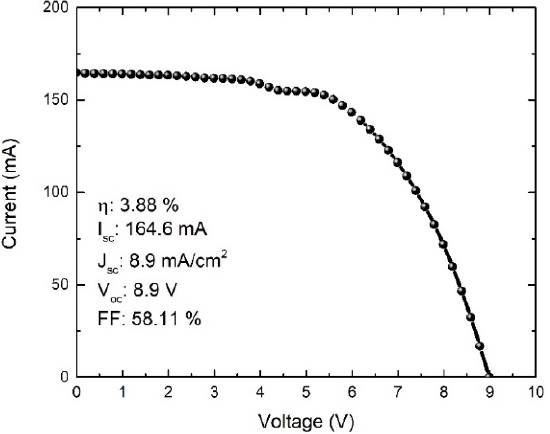
Figure 8. IV curve of the best PCE at 60 °C.